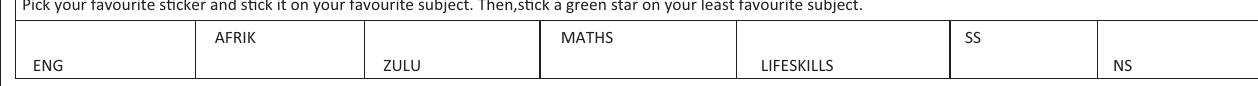
FIGURE 3: Question with subject options.